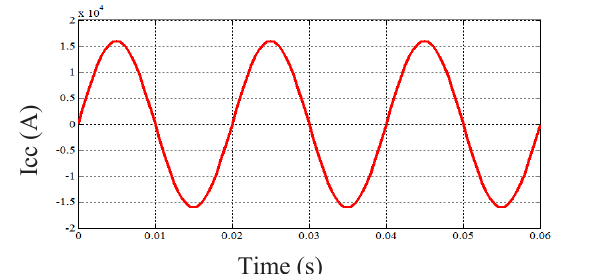
Figure 3: Waveform of the applied short-circuits